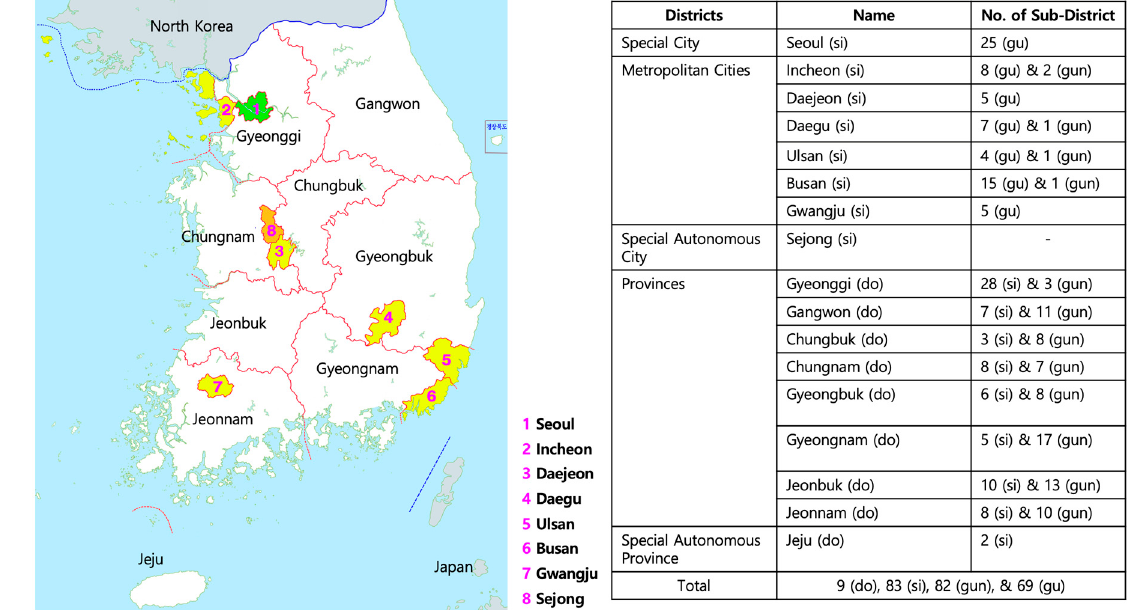
Table 5. Categorization of cities.